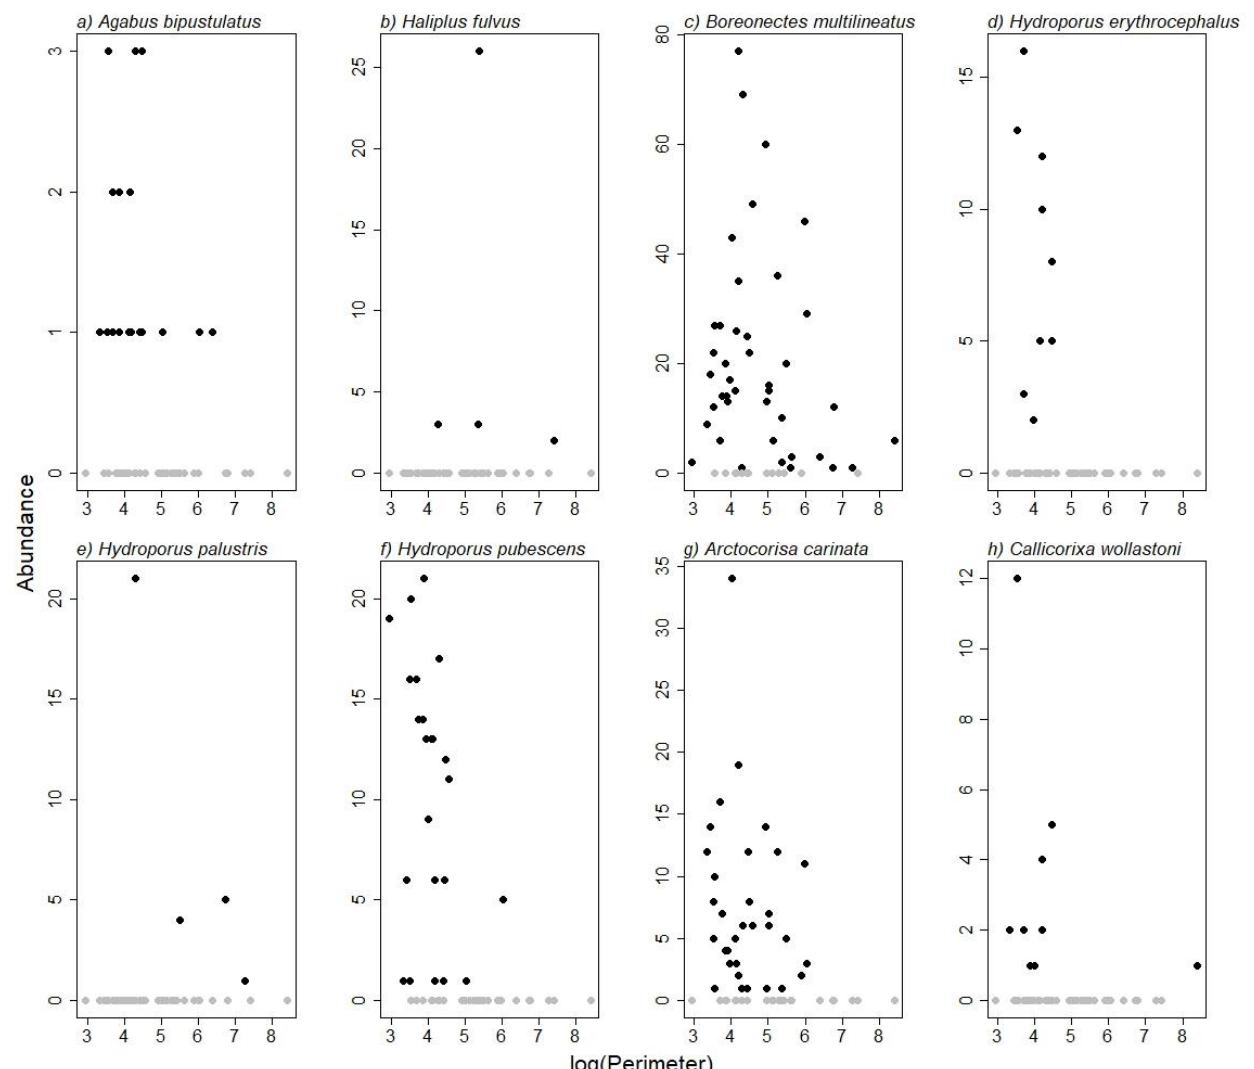
Figure 5. Species-specific relations to pond size. Abundance of water beetles ( a – f ) and water boatmen ( g , h ) in relation to log-transformed shoreline length (perimeter) of the ponds. Ponds in which the species were present are represented as black dots, and ponds in which the species were absent as grey dots.